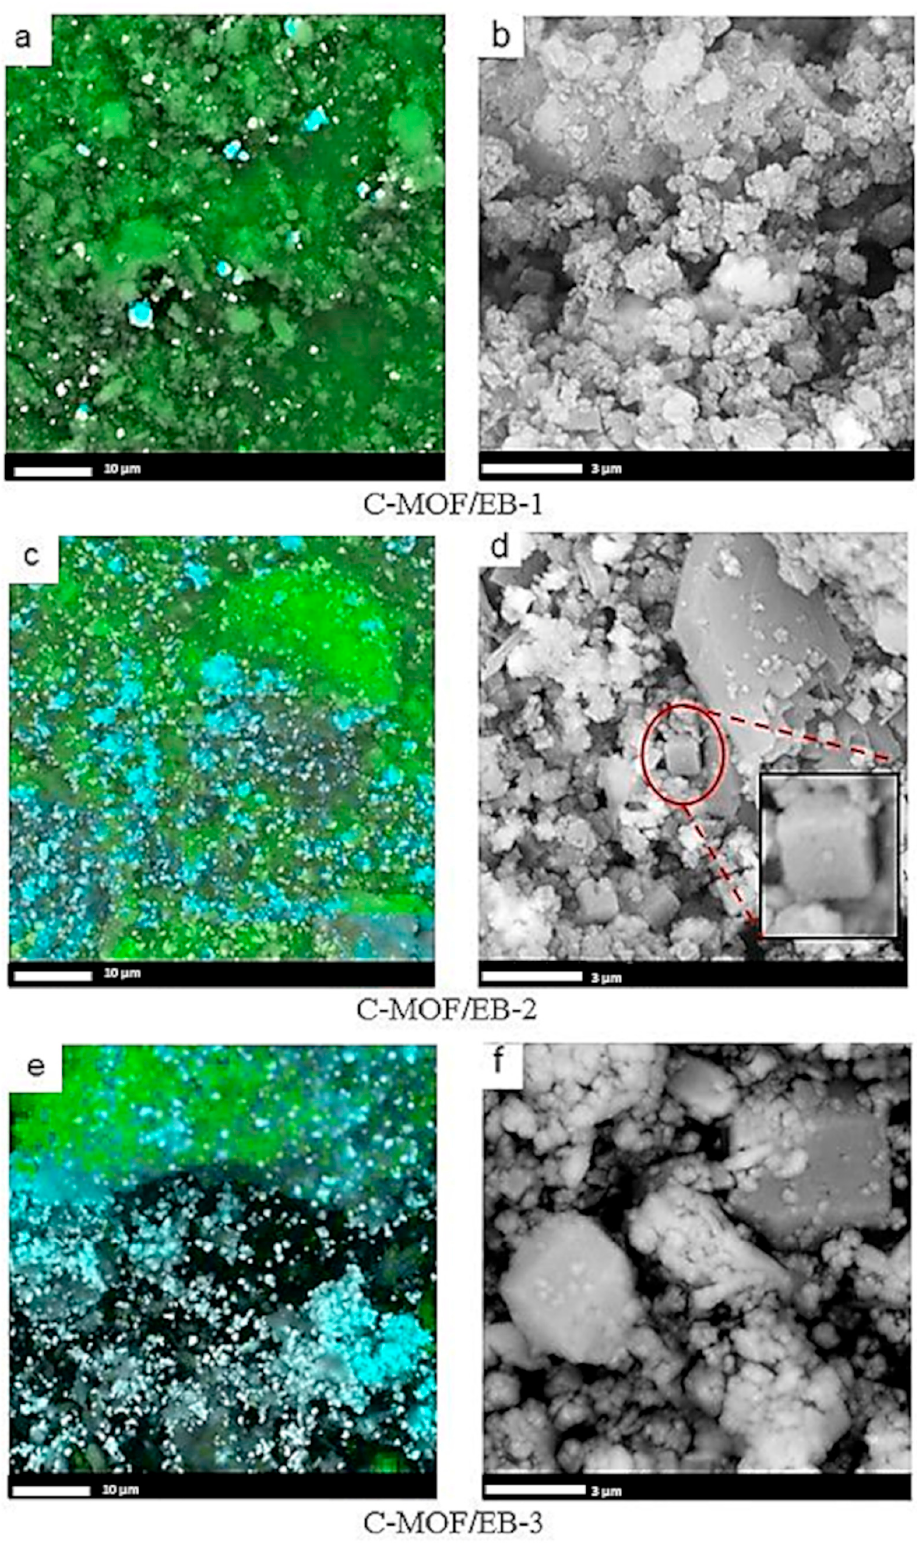
Figure 3. EDX elemental maps ( a , c , e ) and SEM images ( b , d , f ) of C-(MOF-5/PANI) samples of the C-MOF/EB series: ( a , b ) C-MOF/EB-1, ( c , d ) C-MOF/EB-2, and ( e , f ) C-MOF/EB-3. The scale bar on EDX and SEM images is 10 μ m and 3 μ m, respectively. The most abundant elements in EDX maps, C and Zn, are marked with green and turquoise, respectively.